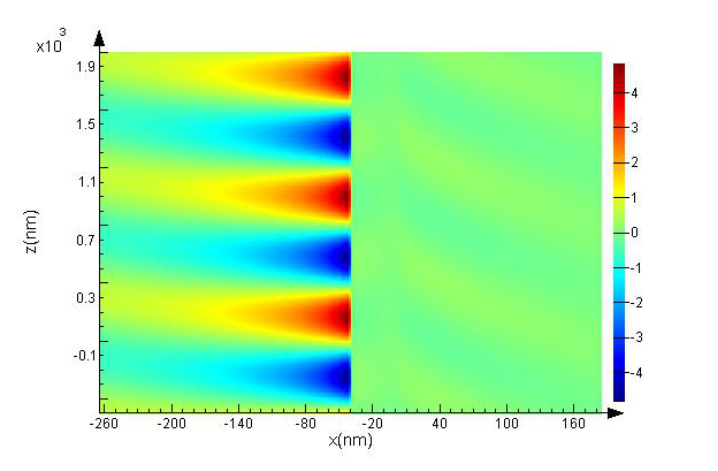
Figure 2. E x component of field enhancement for 800 nm pulse on gold coated blade using finite difference time domain (FDTD) simulations.